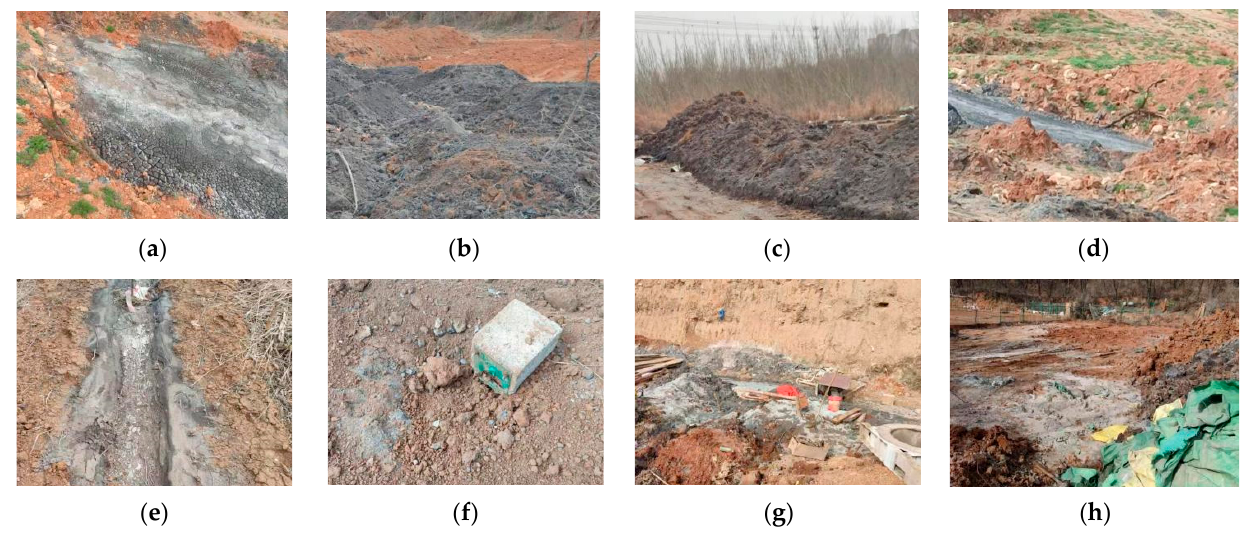
Figure 13. Slurry leakage site photos: ( a ) L1 slurry leakage point; ( b ) L2 slurry leakage point; ( c ) L3 slurry leakage point; ( d ) L4 slurry leakage point; ( e ) L5 slurry leakage point; ( f ) L6 slurry leakage point; ( g ) L7 slurry leakage point; ( h ) L8 slurry leakage point .